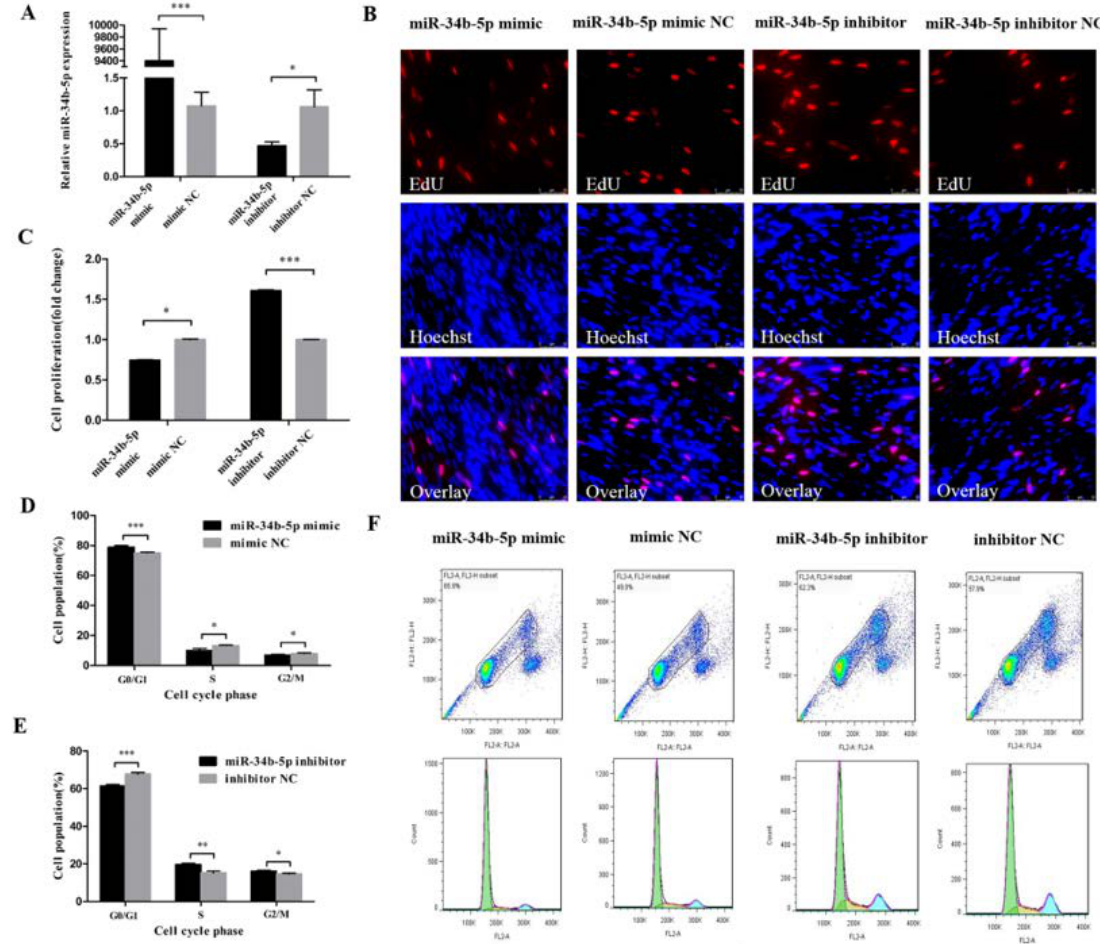
Figure 1. miR-34b-5p represses the cell cycle progression of myoblasts. ( A ) The transfection e ffi ciency of miR-34b-5p after overexpression and inhibition of miR-34b-5p. ( B ) EdU staining after the transfection of miR-34b-5p mimic and inhibitor in chicken primary myoblasts (CPM) cells. ( C ) The proliferation rate of CPM cells transfected with miR-34b-5p mimic and inhibitor. ( D , E ) The statistical results of cell cycle analysis after overexpression and inhibition of miR-34b-5p in myoblast. ( F ) Flow cytometry raw data of cell cycle analysis in myoblasts after overexpression or inhibition of miR-34b-5p. Results are shown as mean ± S.E.M. and the data are representative of at least three independent assays. Independent sample t-test was used to analyze the statistical di ff erences between groups. (* P < 0.05; ** P < 0.01, *** P < 0.001). Please provide a sharper